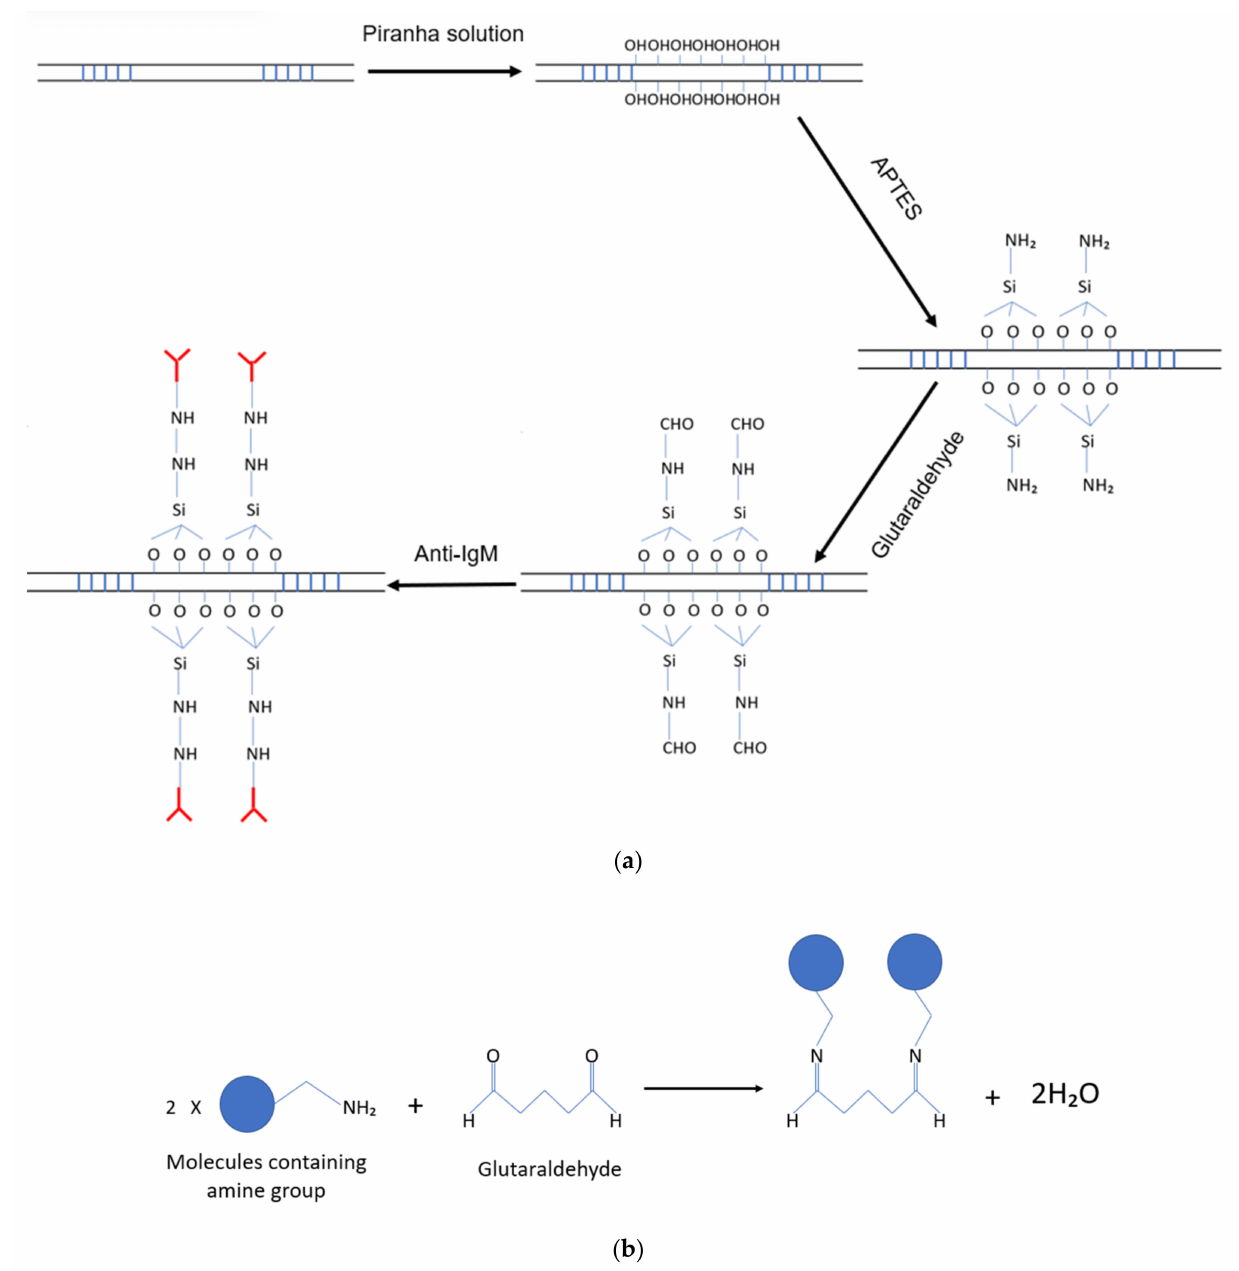
Figure 4. ( a ) The surface functionalisation of LPGMZI. ( b ) Glutaraldehyde works as